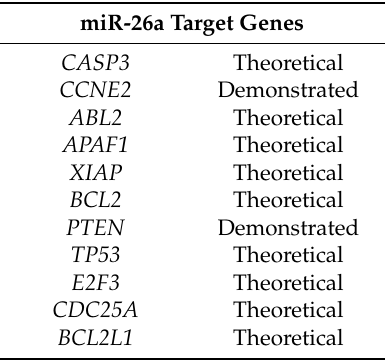
Table 1. Theoretical and demonstrated miR-26a selected gene targets obtained with miRTarBase, and selected by DAVID Bioinformatics Resources and miRBase. Demonstrated targets are experimentally proveN targets by techniques such as RT-qPCR or Western Blot, although none of them are proven in breast